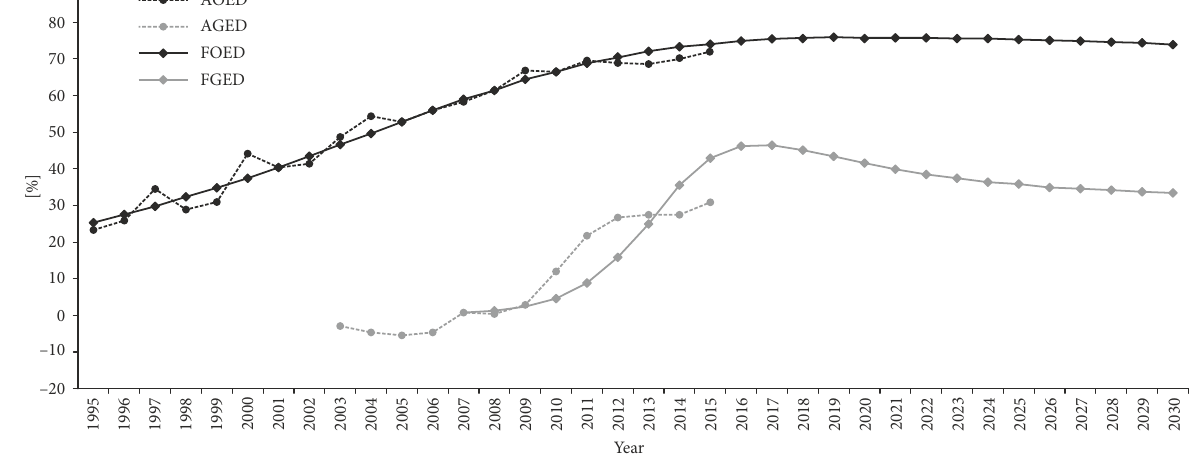
Figure 4. The AOED, AGED, FOED and FGED changing